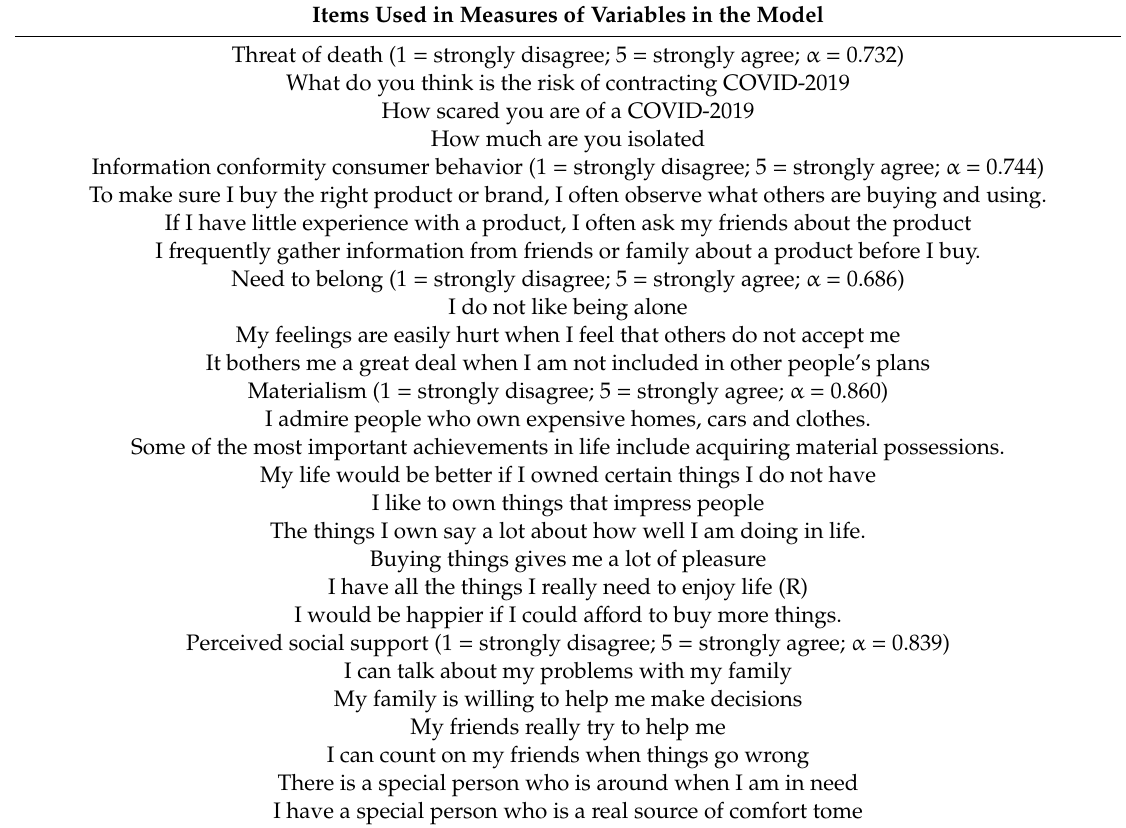
Table A1. Research scales in this study. Items Used in Measures of Variables in the